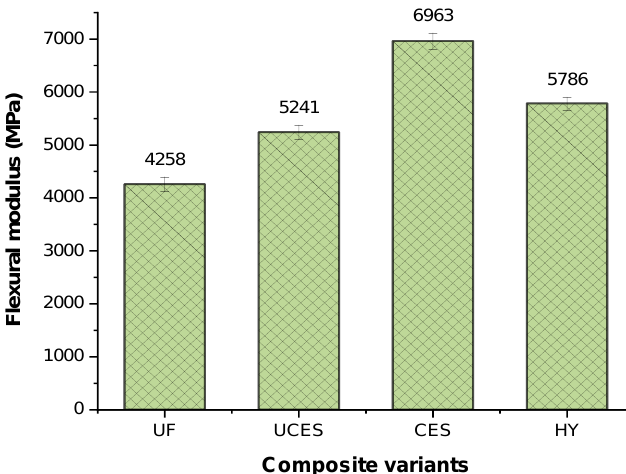
Figure 7. Flexural strength comparison of composite variants.